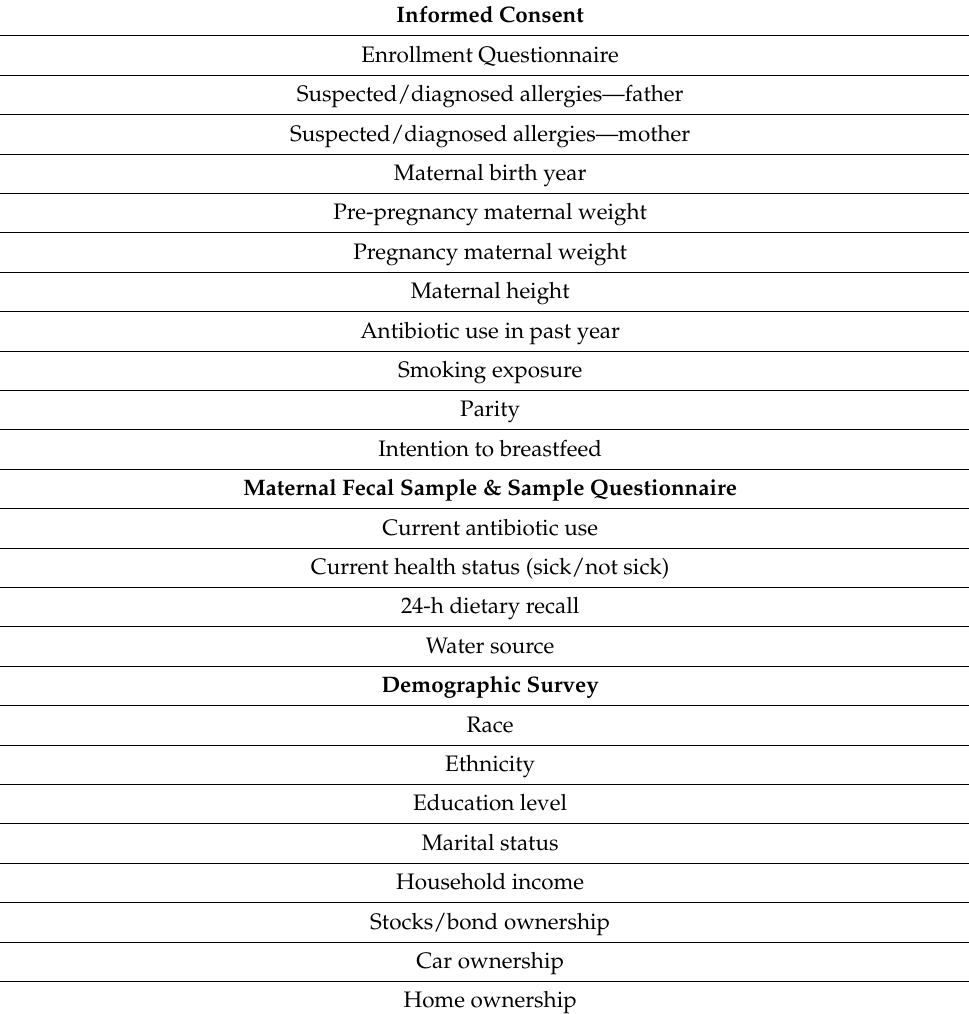
Table 1. Overview of maternal data and samples collected during pregnancy.